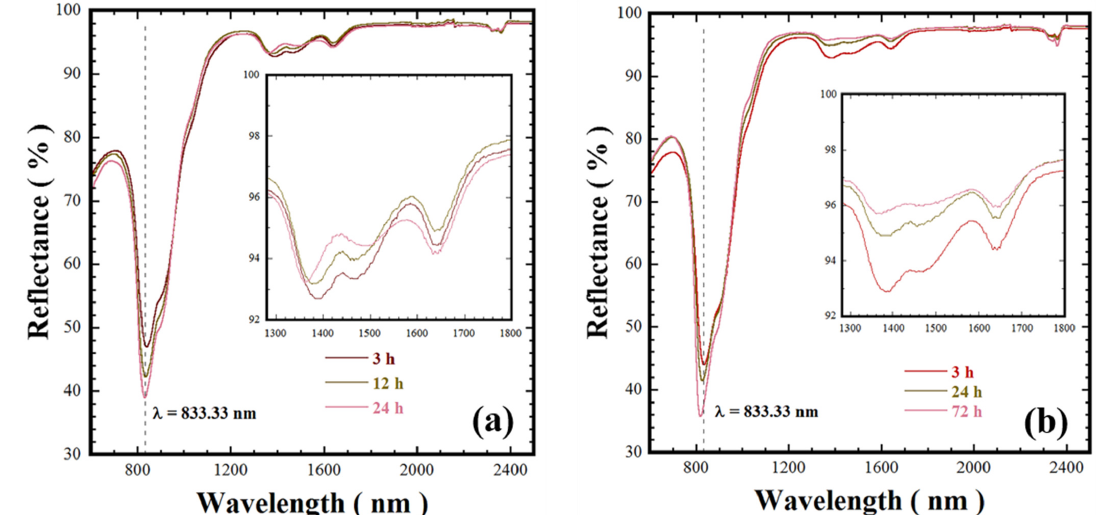
Figure 7. Near infrared reflectance spectra of the Victorian green pigments hydrothermally prepared in a 5.0 M KOH solution (12.5 mL) with 3.0 mole of Si 4+ and no autoclave agitation. The powder pigments were synthesised at various reaction intervals and temperatures of ( a ) 200 and ( b ) 240 °C.